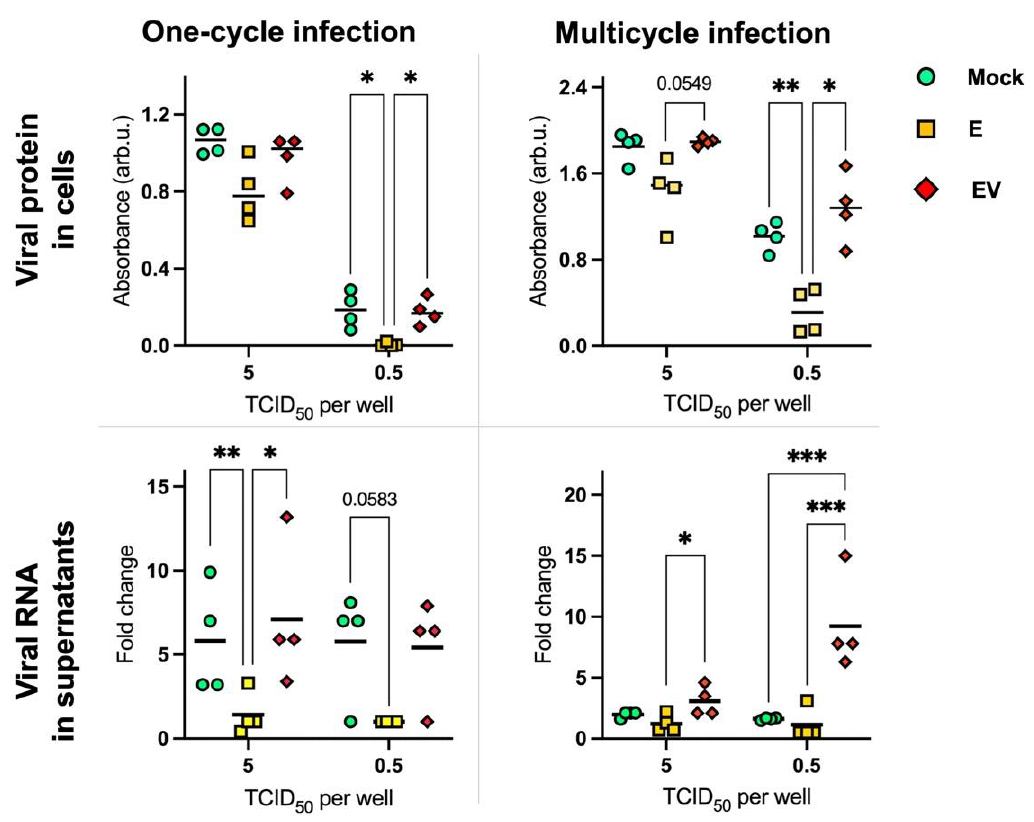
Figure 5. Viral protein (nucleoprotein) levels in cells and viral RNA in supernatants after IAV infection of A459 cells (treated with E, EV, or mock-treated) 20 h post-infection without trypsin (one-cycle-infection) and 48 h post-infection with trypsin (multicycle infection). The statistical analysis was performed using two-way ANOVA: *** — p < 0.001; ** — p < 0.01; * — p < 0.05. p values of 0.0549 and 0.0583 (not significant) are marked. To calculate fold change, the mean gene expression in E was considered as 1.